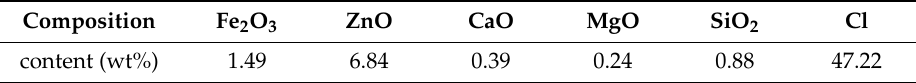
Table 7. Test results for element content in a leaching experiment with Na 2 CO 3.